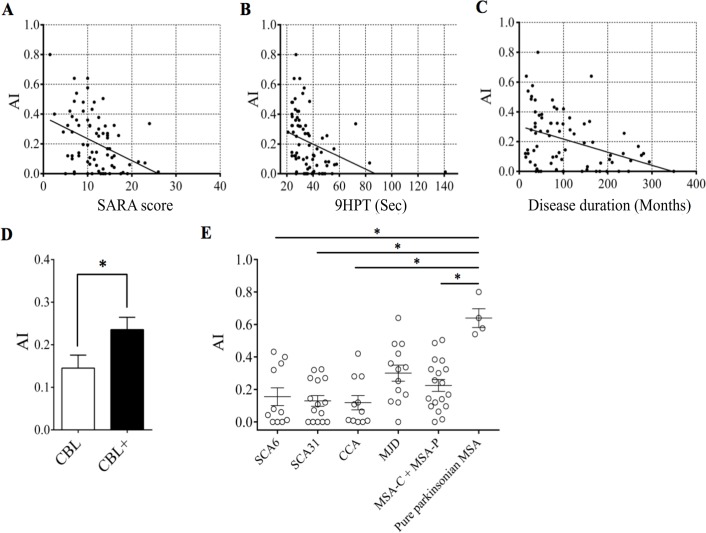

AI and other clinical indexes in various cerebellar diseases.(A)–(C) Scatter plots comparing AI with SARA score (A), 9-Hole Peg Test (B), and disease duration (C) in CN and CE patients. Linear regression lines are overlaid. (D) Comparison of AI between the CBL (n = 24) and CBL+ (n = 32) groups. *p < 0.05 by Mann-Whitney U-test. Error bar represents SEM. (E) AI was significantly higher in pure parkinsonian MSA patients than in SCA6, SCA31, CCA, or MSA (MSA-C and MSA-P) patients. *p < 0.05, post hoc Steel-Dwass test.